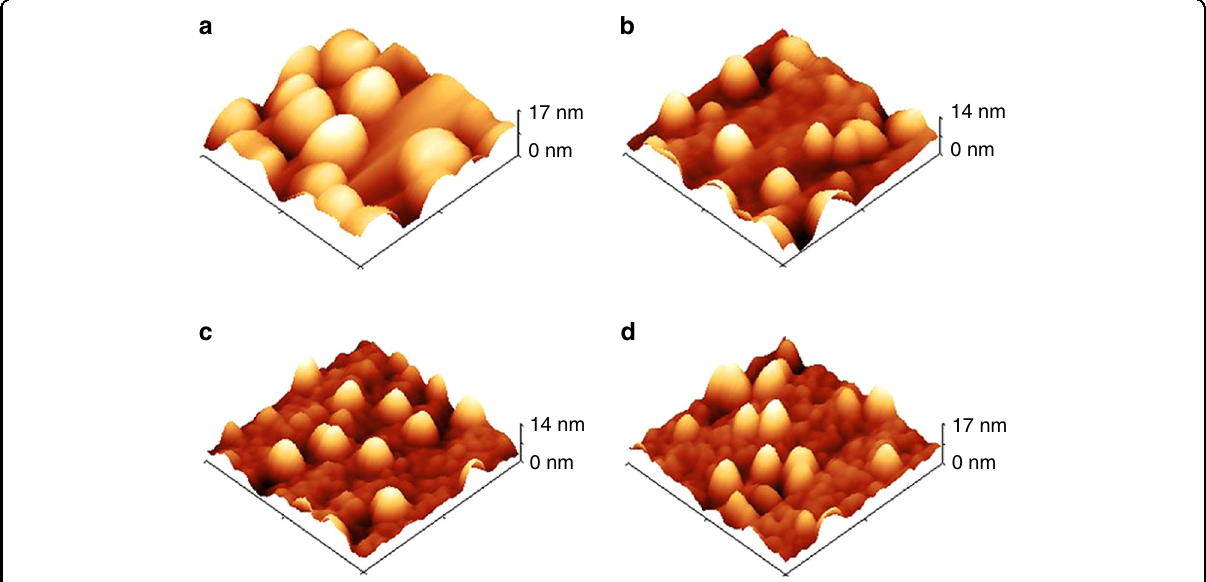
Fig. 4 InN QDs in 3D AFM (300 nm) 2 scans. Continuously grown GaN cap thicknesses of ( a ) 0, ( b ) 12, ( c ) 18, and ( d ) 23 nm. From Reilly et al., Phys. Status Solidi Basic Res. 257 , 1900508 (2020) © 2019 WILEY-VCH Verlag GmbH & Co. KGaA, Weinheim